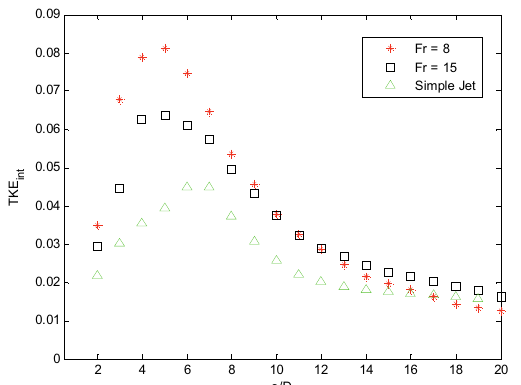
Figure 7. Streamwise decay of the integral non- dimensional Turbulent Kinetic Energy TKE/U max2 in the near-field of an INBJ with Re = 1000, θ = 65° and different Fr (red: asterisks 8, black squares: 15) and of a simple jets with the same Re (green triangles).